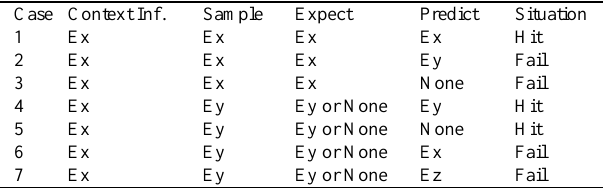
Table 1: Accuracy results with and without Context Information Definition of Hits and Fails for sample measurements.